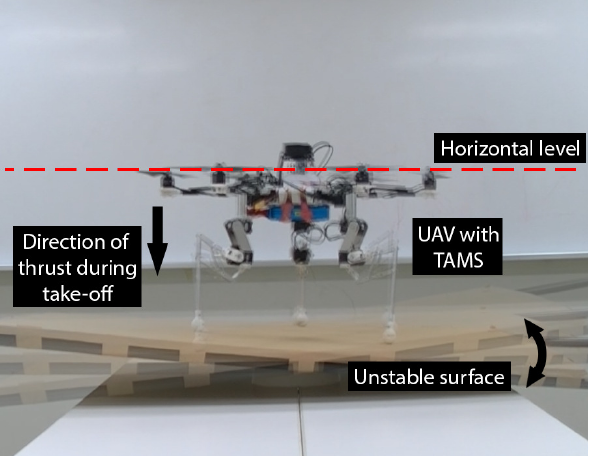
Figure 1. The UAV with three-arm aerial manipulator system landed and ready to take off from an unstable platform with changing